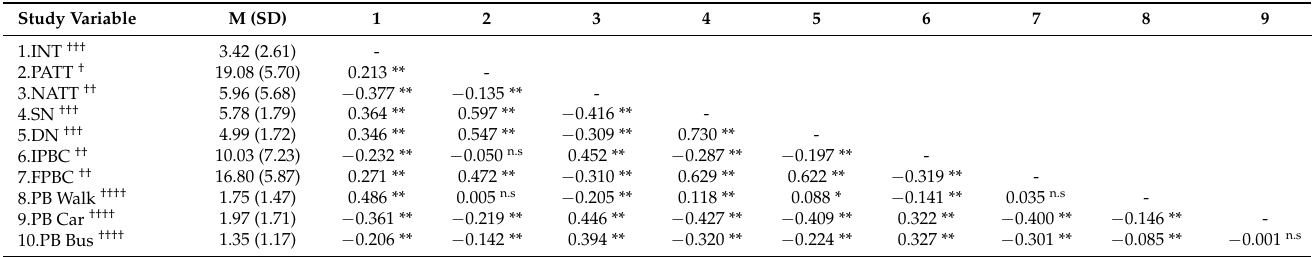
Table 4. Means, standard deviations and zero-order Pearson correlations among the various walking components. Study